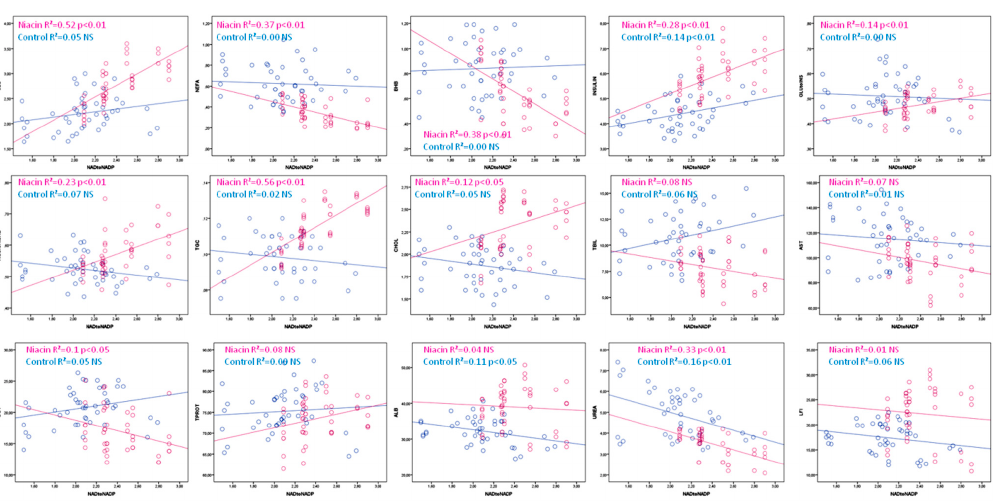
Figure 5. Linear regression line between the NAD:NADP index and metabolic parameters in cows receiving (purple) and not receiving niacin (blue).